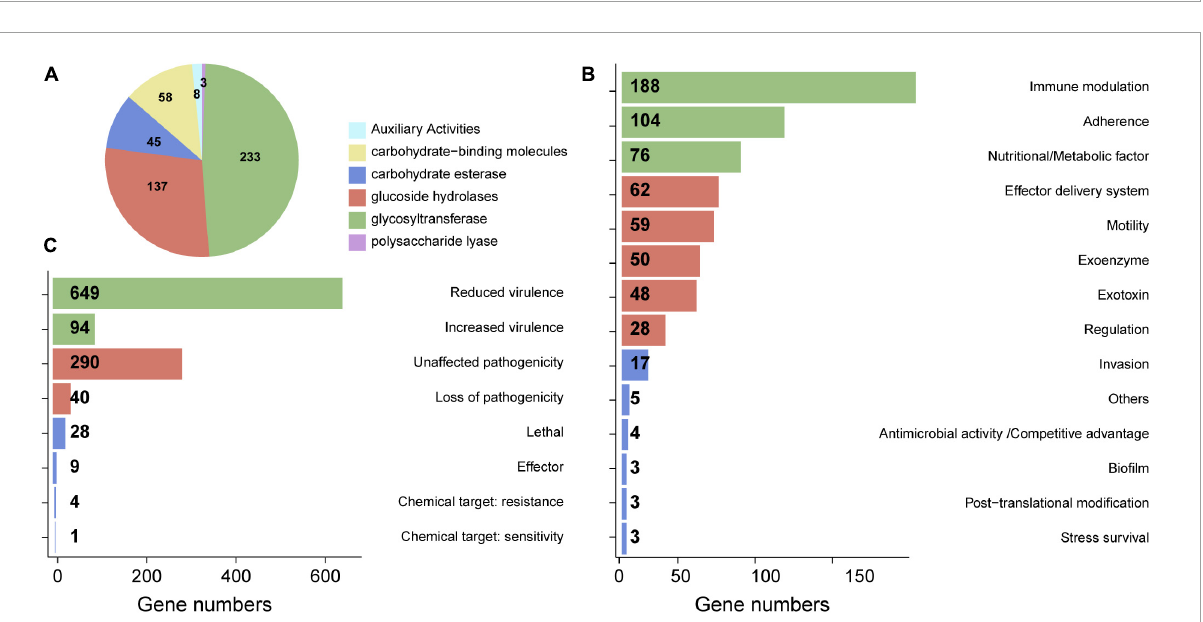
FIGURE2 The annotation of CAZymes, VFDB, and PHI in B. pumilus HM-7 genome. (A) Distribution of CAZymes categories and gene number. (B) The functional categories of the B. pumilus HM-7 virulence genes according to the classification in the VFDB. (C) PHI classification and the genes number in HM-7. The list of genes are presented in Supplementary Tables 3–5